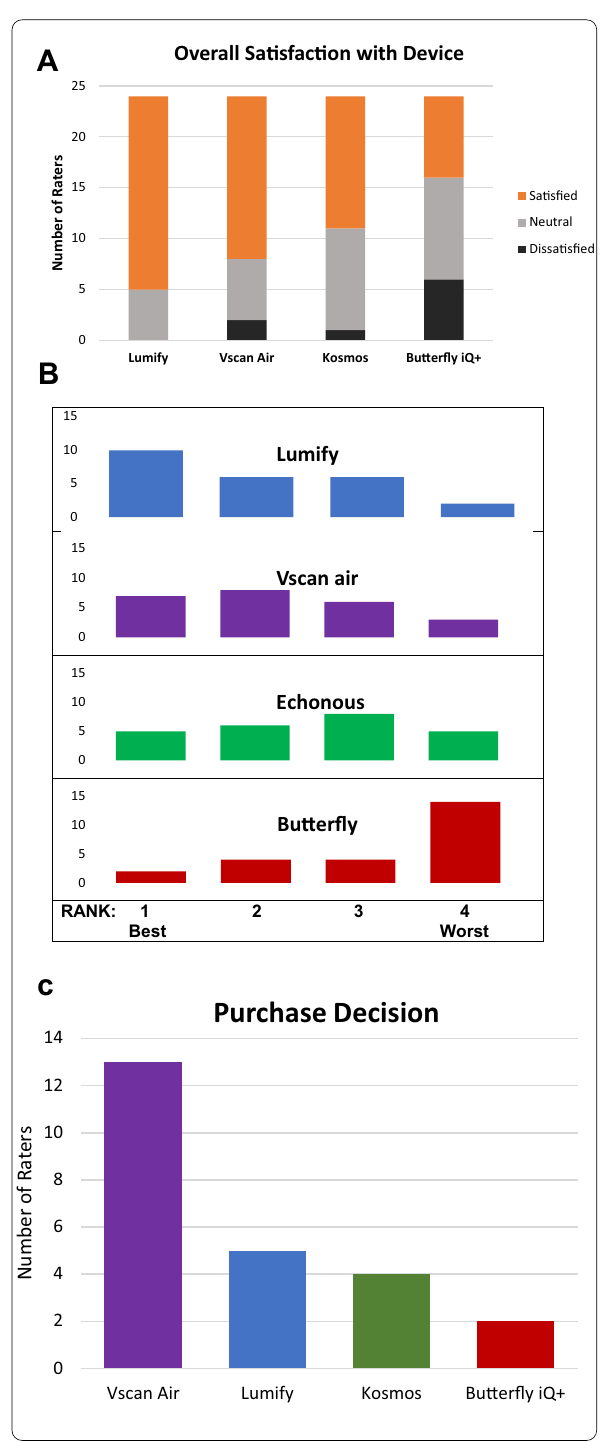
Fig. 3 A Overall satisfaction with handheld ultrasound devices per POCUS Experts. Experts’ responses were defined as Satisfied for "I like this device and would definitely use it in patient care", Neutral for “I don’t have strong feeling for or against this device. I might use it in patient care,” and Dissatisfied for “I would not use this device even if it was given to me for free.” B Overall Ranking of Handheld Ultrasound Devices by POCUS Experts. C Recommendation for Purchase of a Personal Handheld Ultrasound Device by POCUS Experts